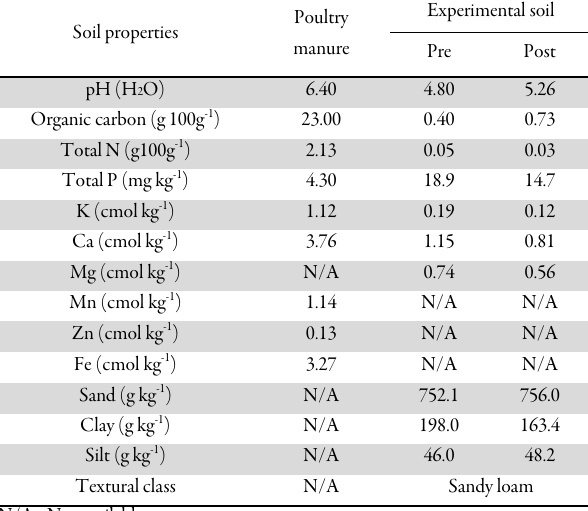
Table 1. Physical and chemical properties of poultry manure and soil of the experimental site pre plant and post-harvest Soil